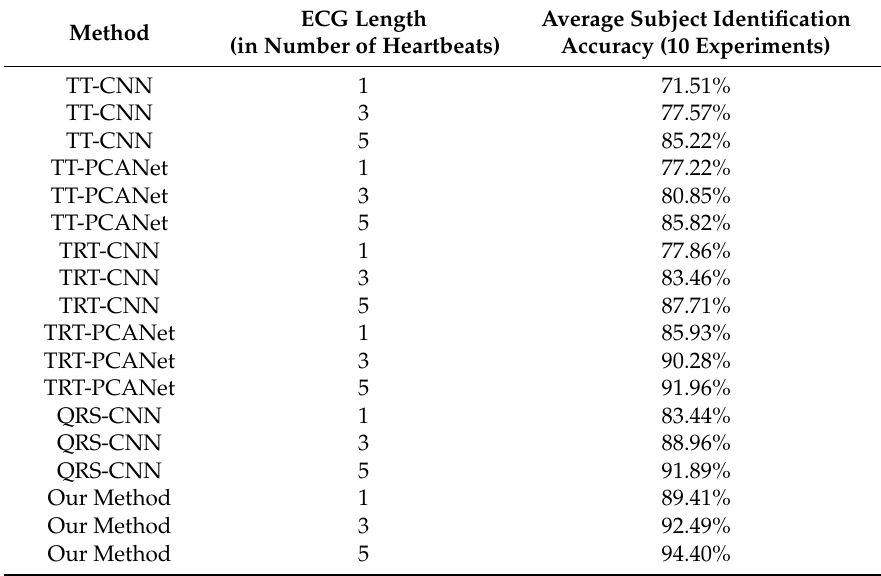
Table 5. The comparison of subject accuracies among short-term ECG signals with different heartbeat length. ECG Method